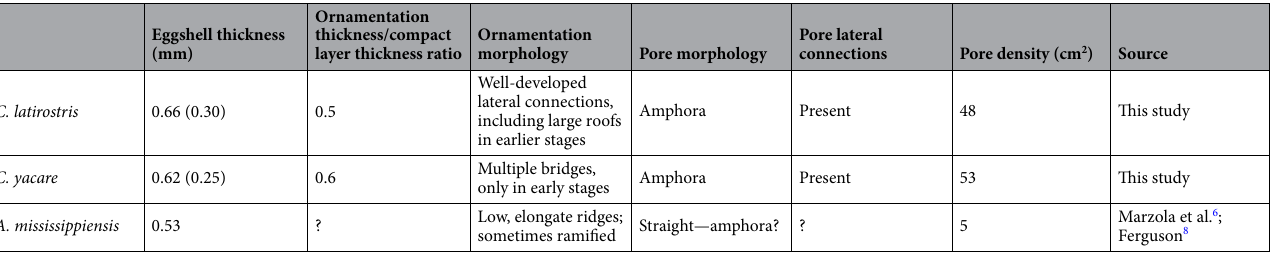
Table 2. Morphological features that characterize the eggshells of some alligatorids. *Values in parenthesis correspond to thickness without considering ornamentation (i.e. compact layer). Note that although C. latirostris and C. yacare share columns and walls in there ornamentations, the development of lateral interconnections is greater C. latirostris